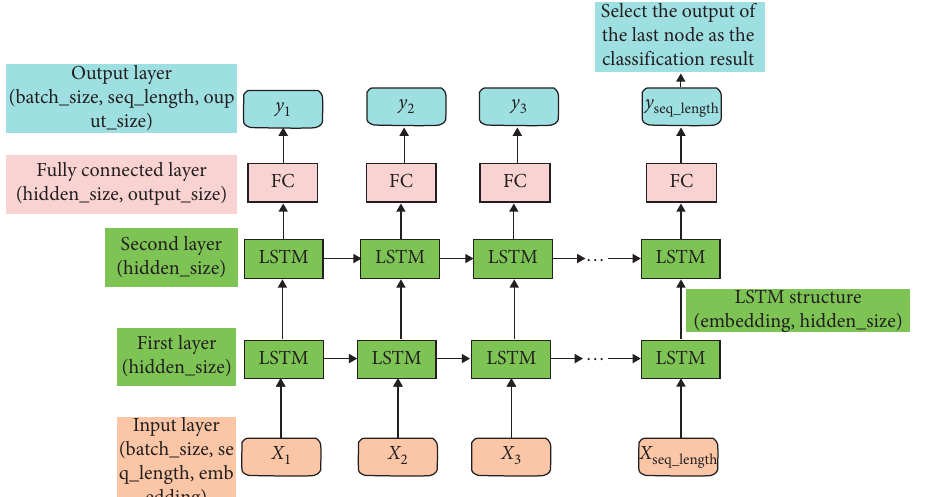
Figure 2: Vehicle behavior recognition model.